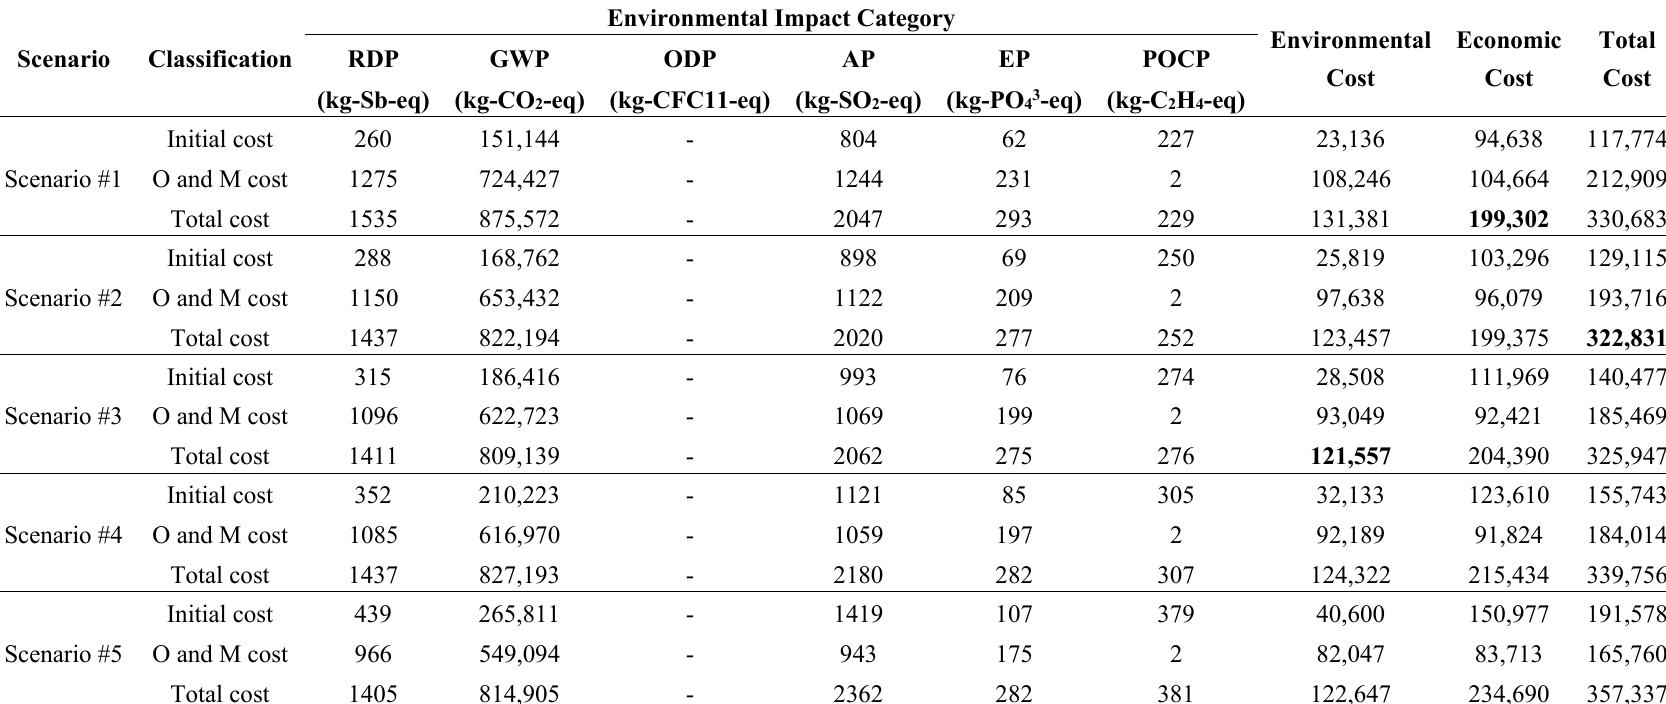
Table 5. Life-cycle environmental and economic cost of